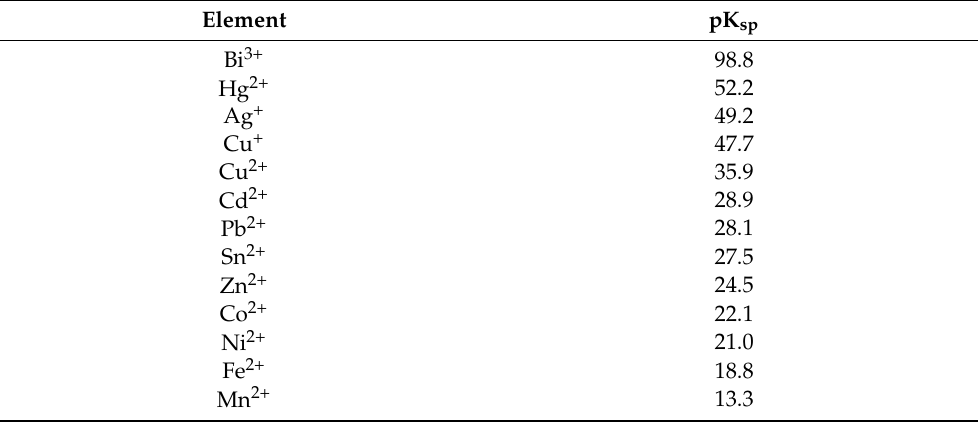
Table 1. Solubility products (pK sp ) at 25 ◦ C for selected elements. Adapted from